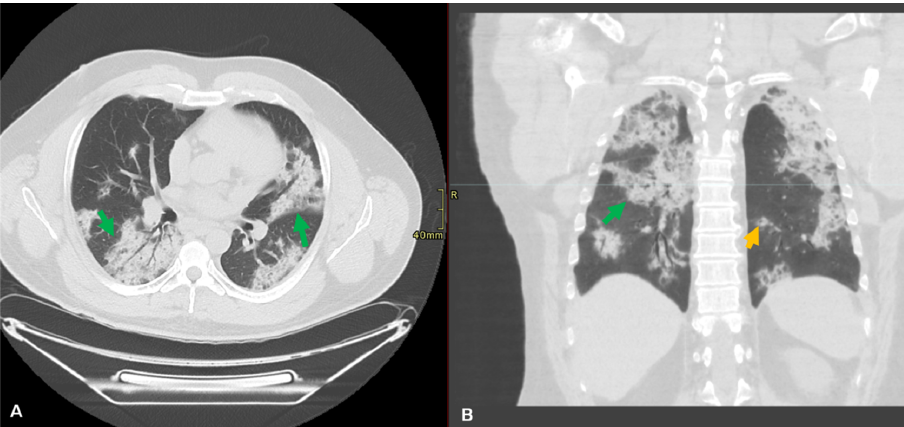
Figure 4. Lung of a 51-year-old male patient with a history of hepatitis C and symptoms of dry cough and shortness of breathing for three weeks. No recent travel or known contacts with infected subjects. Axial ( A ) and coronal computed tomography (CT) ( B ) of chest without contrast revealed bilateral peribronchial and subpleural consolidative opacities noted throughout both lungs (green arrow). There were scattered nodular consolidative opacities in a peribronchial distribution (orange arrow). The patient tested positive for SARS-CoV-2 RNA.